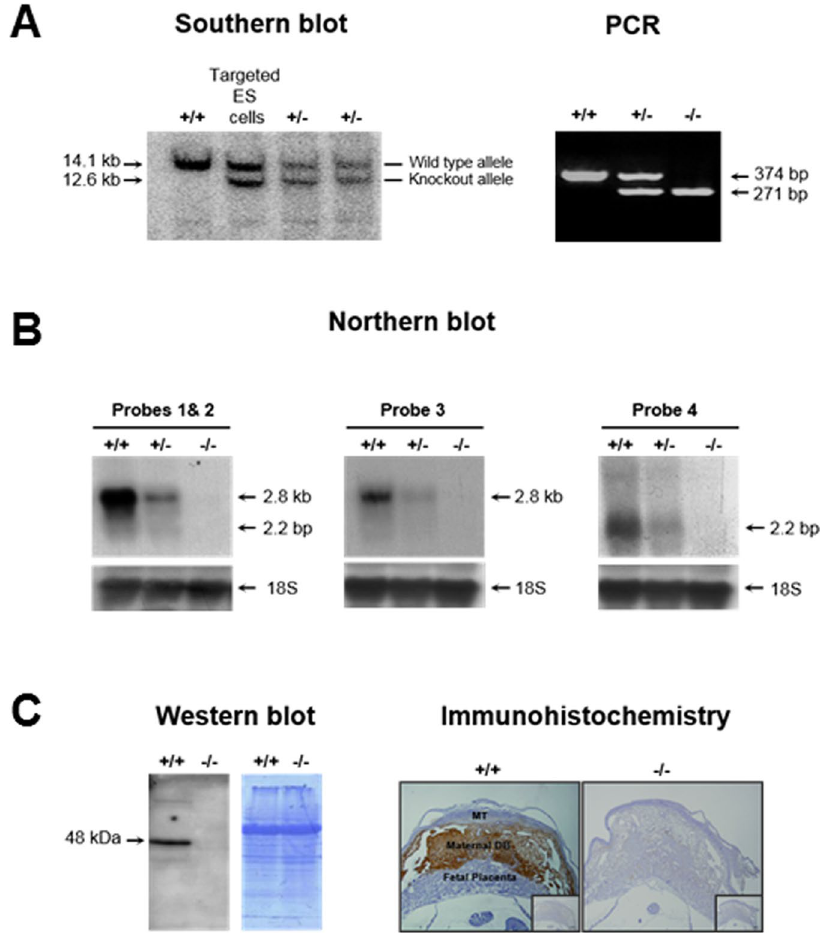
Figure 1. Confirmation of HtrA3 gene deletion in the mouse. ( A ) Southern blot analysis. Tail DNA from the wild type ( + / + ) and first generation heterozygous ( + / − ) mice, and genomic DNA from targeted ES cells, were digested with Sap1 and analyzed with the 3 ′ probe shown in Supplementary Fig. 1B. The band size of the wild type (14.1 kb) and the null (12.6 kb) alleles are shown. PCR analysis. Tail DNA from 3 representative HtrA3 genotypes of mice were analyzed by PCR using the 3 genotyping primers (F, R1 and R2) illustrated in Supplementary Fig.1C; the resulting products (374 and 271 bp) and band pattern were precisely as predicted. ( B ) Northern blot analysis. Total RNA from d10.5 implantation sites were analyzed by the 4 distinct probes shown in Supplementary Fig. 1(A). Probe 1, specific to exon 1 (deleted); probe 2, downstream of the deleted region and common to both HtrA3 mRNAs; probe 3, specific to HtrA3 L-mRNA (~2.8 kb); probe 4, unique to HtrA3 S-mRNA (~2.2 kb). Detection with probe 4 required a much longer exposure because of much lower expression of the HtrA3 S-mRNA. ( C ) Western blot analysis. Total protein lysates from d10.5 implantation sites were examined on two identical gels. Left panel, Western blot analysis; right panel, Coomassie blue staining showing equal loading. Immunohistochemistry. D10.5 implantation sites were analyzed, HtrA3 was immuno- stained (brown) predominantly in maternal decidua basalis of + / + but not − / − mice; the inserts are negatives. MT, maternal uterine metrial triangle. An antibody detecting both HtrA3 protein isoforms were used for the protein